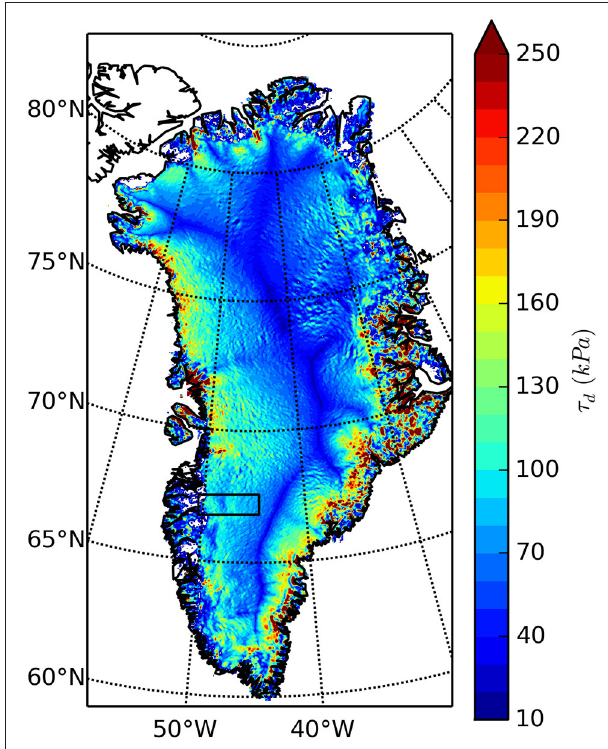
FIGURE 1 | Driving stress calculated over the GrIS. Surface slopes are calculated over a 4 km length scale as described in the text. Black box outlines study area displayed in Figure 2